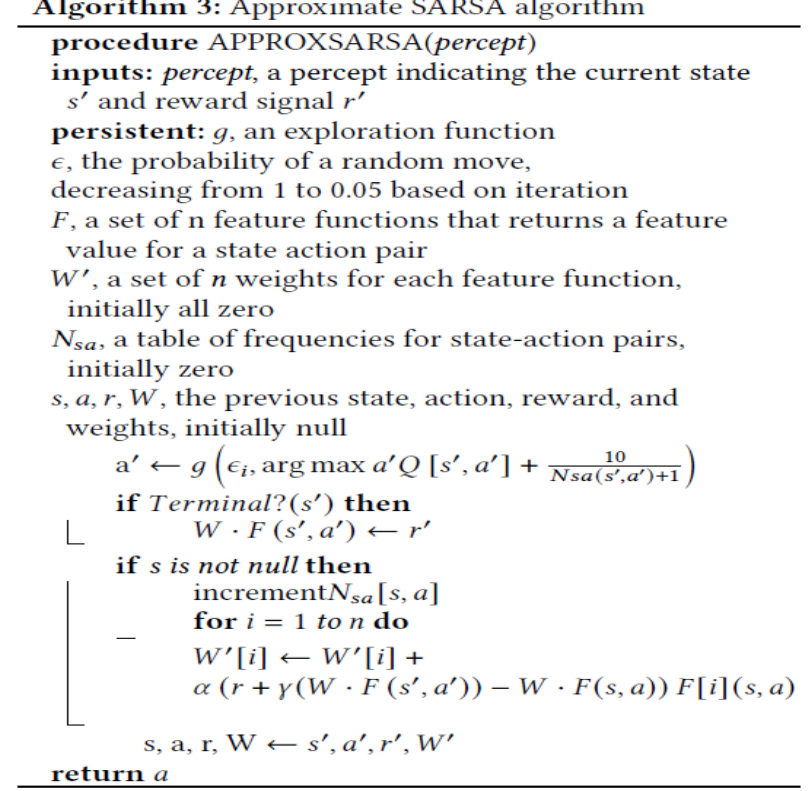
Figure 9. The algorithm used for approx SARSA.